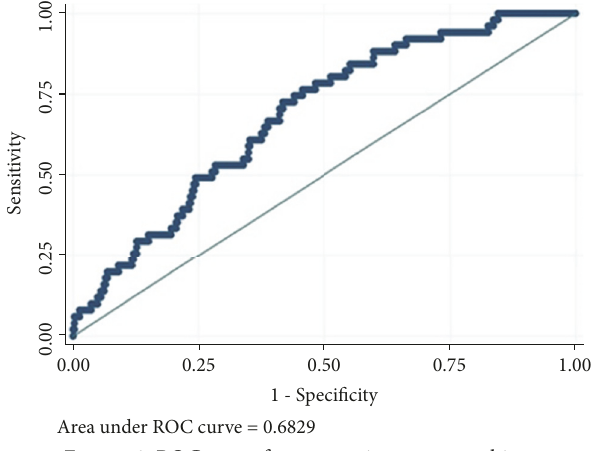
Figure 2: ROC curve for propensity score matching.